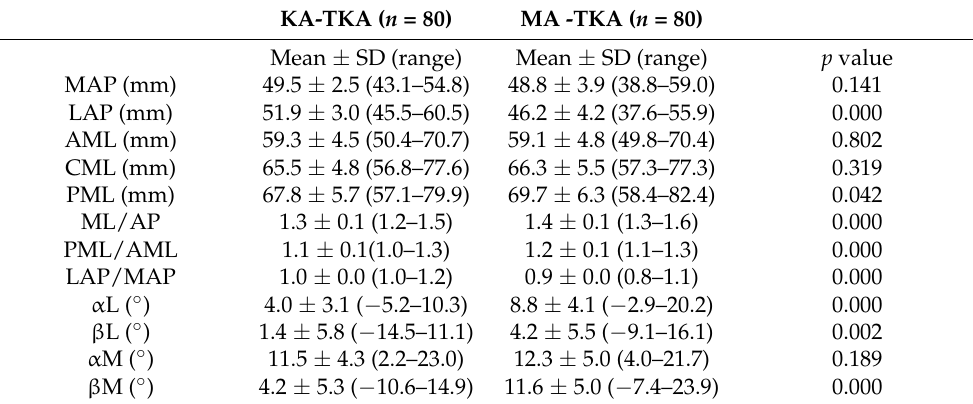
Table 2. Distal femoral